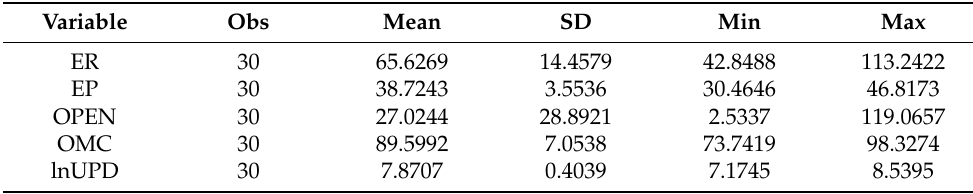
Table 6. Descriptive statistics of